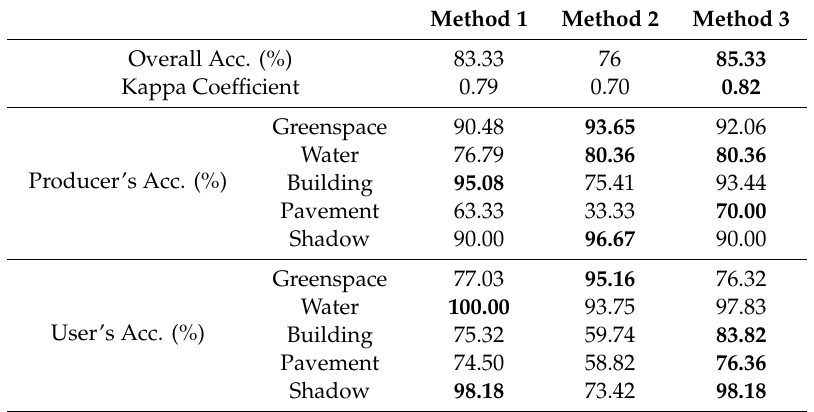
Figure 7. The classification results of the three methods. Table 3. The classification accuracies in Method 1–3. Bold values refer to the highest